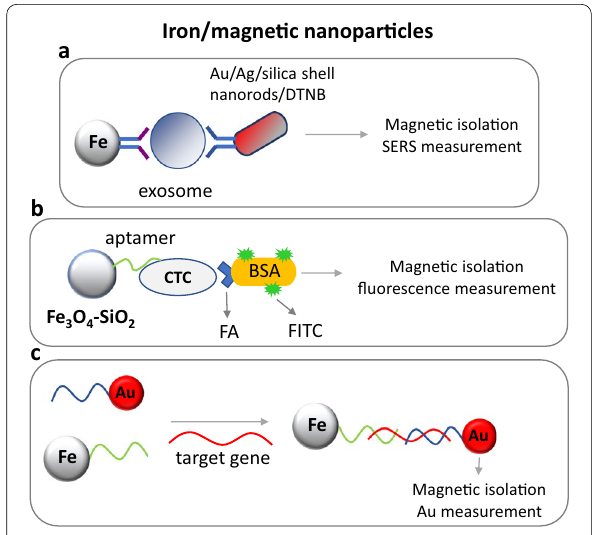
Fig. 6 a Exosomes detection using Au/Ag/silica shell nanorods and magnetic nanoparticles coupled to specific antibodies and SERS measurement. b Circulating cancers cells (CTCs) are detected by magnetic Fe 3 O 4 -silicon nanoparticles conjugated to a specific aptamer. The detection was achieved by FITC/FA-labeled BSA.